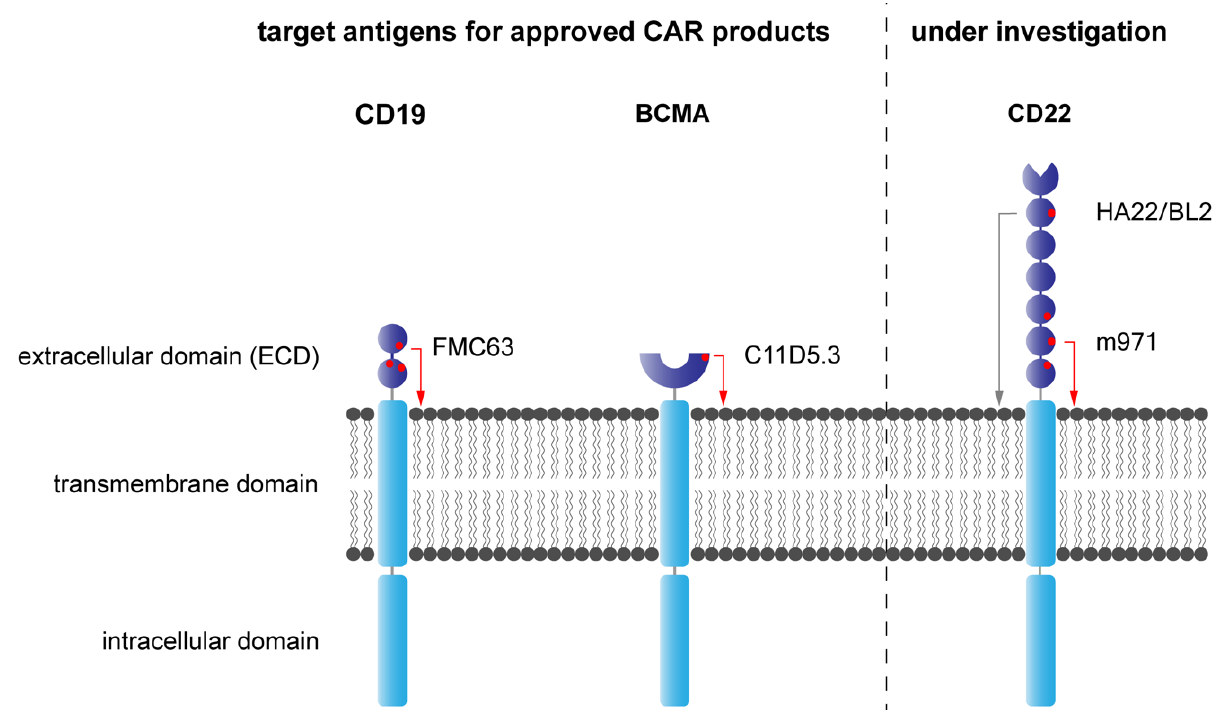
Figure 4. Mechanistic challenges of CAR-targeted antigens.